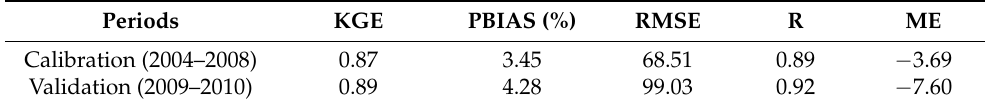
Table 2. Evaluation indices of runoff simulation based on Scheme I.